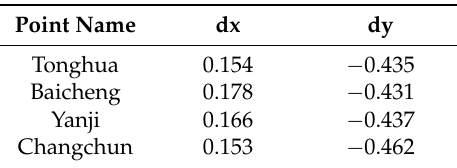
The horizontal difference (UTM Projection) of geodetic coordinates between WGS84 (ITRF2008) and CGCS2000